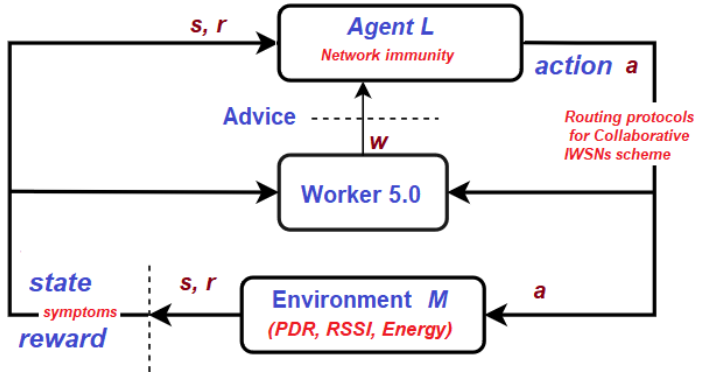
Figure 21. Worker 5.0 — IWSN interaction in Reinforcement Learning.